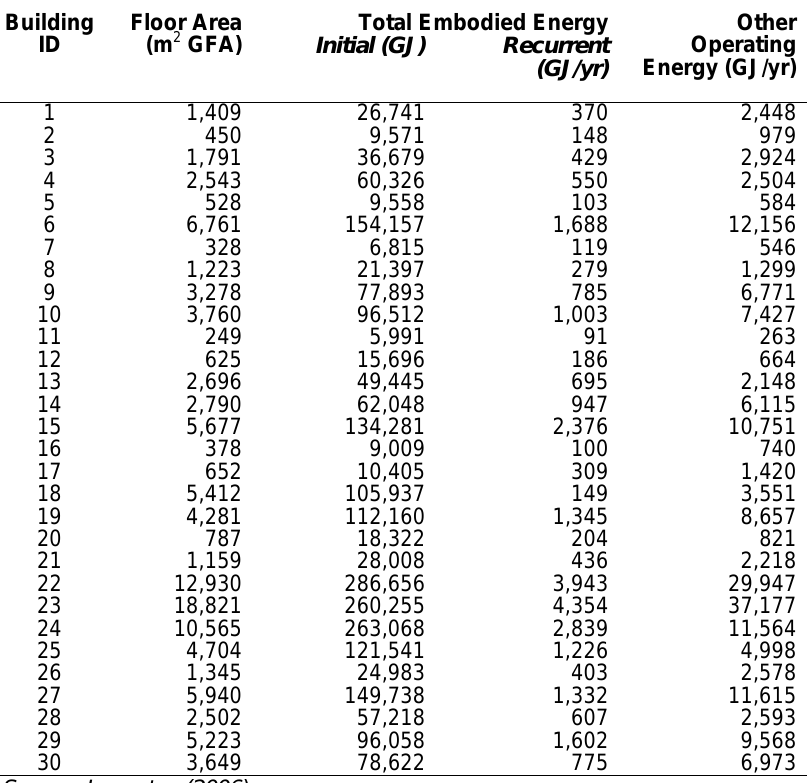
Table 2: Case study energy